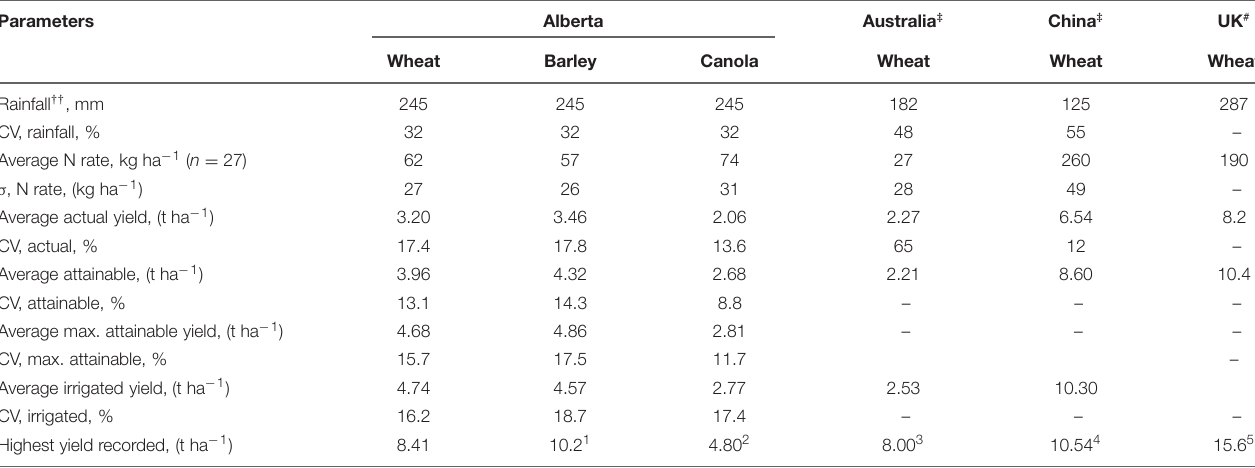
TABLE 4 | Actual, attainable, maximum attainable, and irrigated yields of wheat, barley, and canola over a period of 10 years (2005–2014) in Alberta † . Parameters